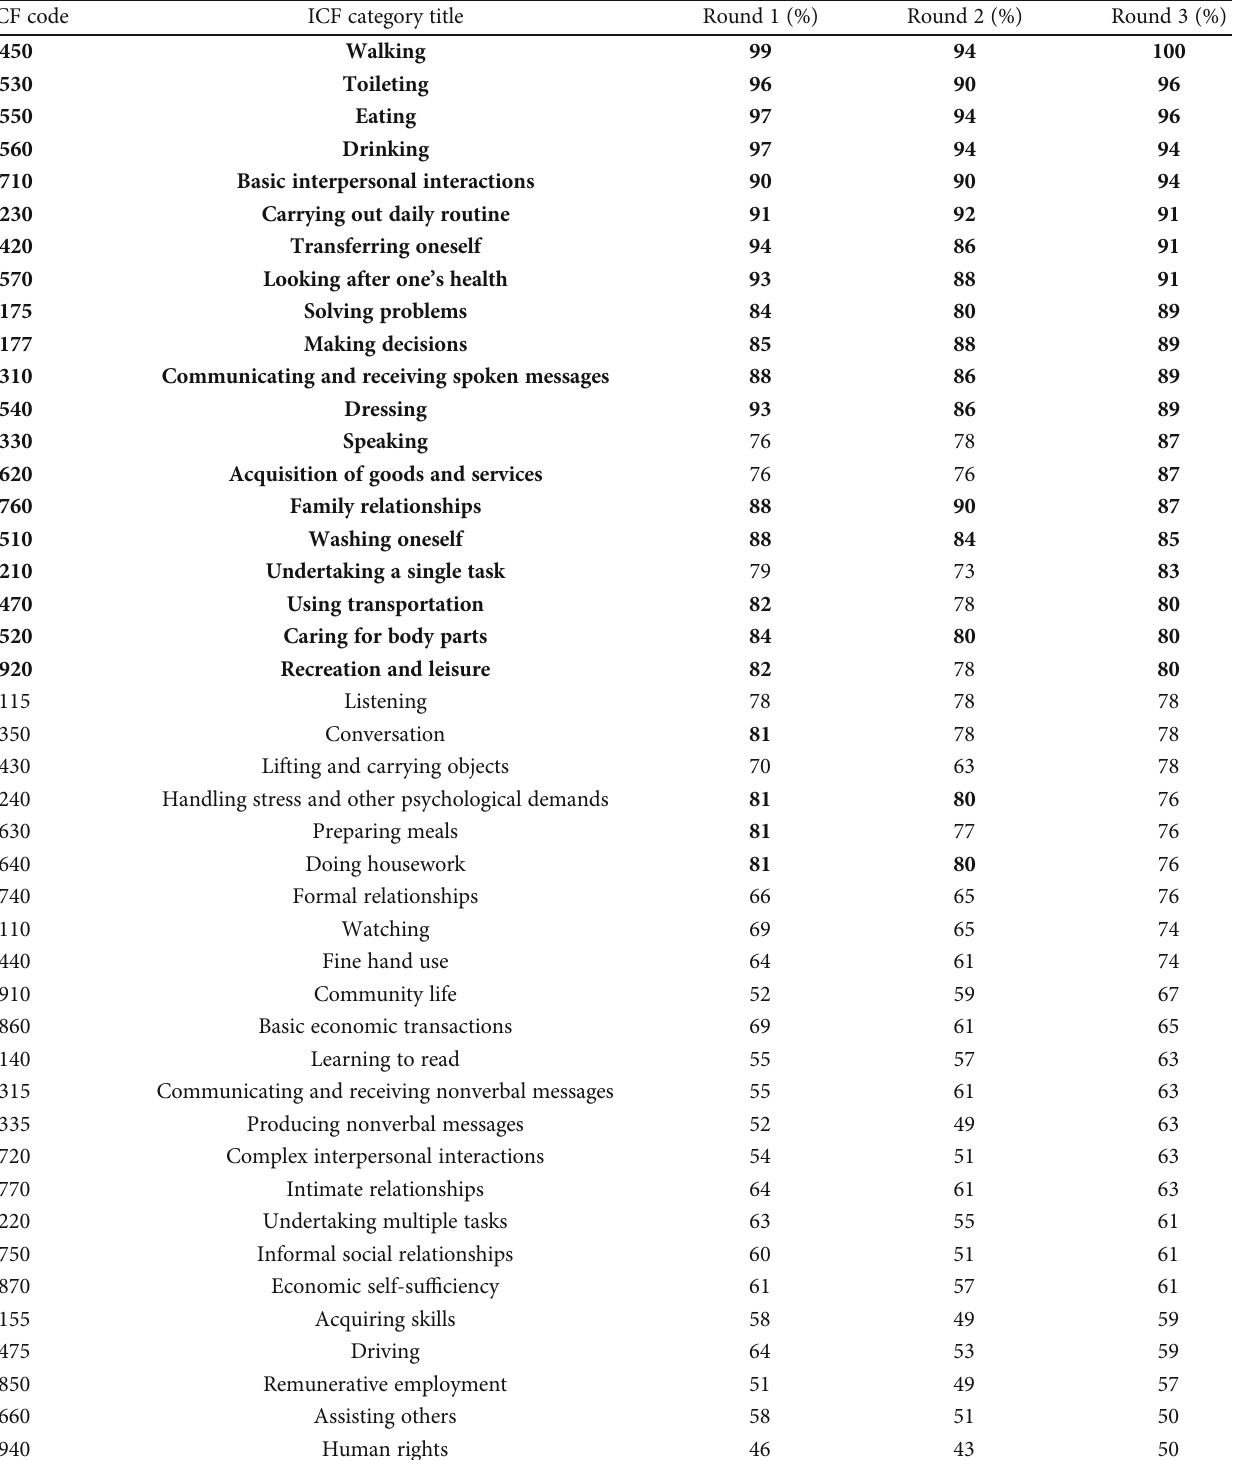
Table 5: International Classi fi cation of Functioning, Disability, and Health (ICF) activity and participation categories that were considered relevant by ≥ 50% of participants in the third round (items in bold with ≥ 80%